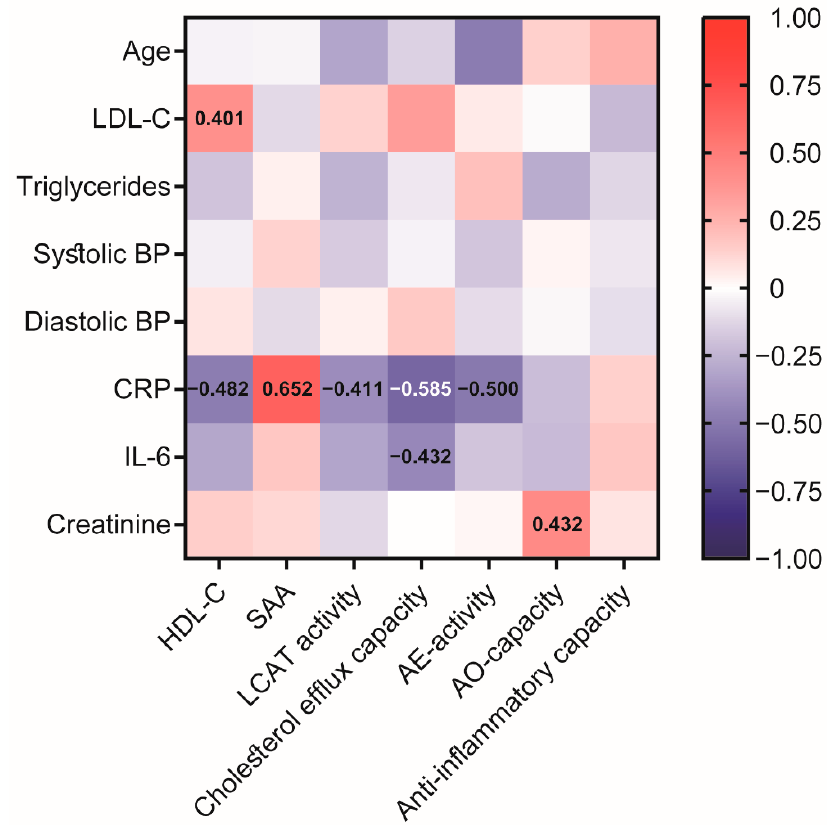
Figure 2. Heatmap representing correlations between HDL-related parameters and clinical data in the COVID-19 patients at baseline. Each cell of the heatmap represents pairwise Spearman correlation between the two parameters indicated in the respective row and column. Correlations that reached significance after Bonferroni correction are indicated with the corresponding Spearman correlation coefficient. Non-significant correlations can still be inferred from the color but are not explicitly indicated. BP, blood pressure; CRP, C-reactive protein; IL-6, interleukin-6; LCAT, lecithin cholesteryl acyltransferase; SAA, serum amyloid A.